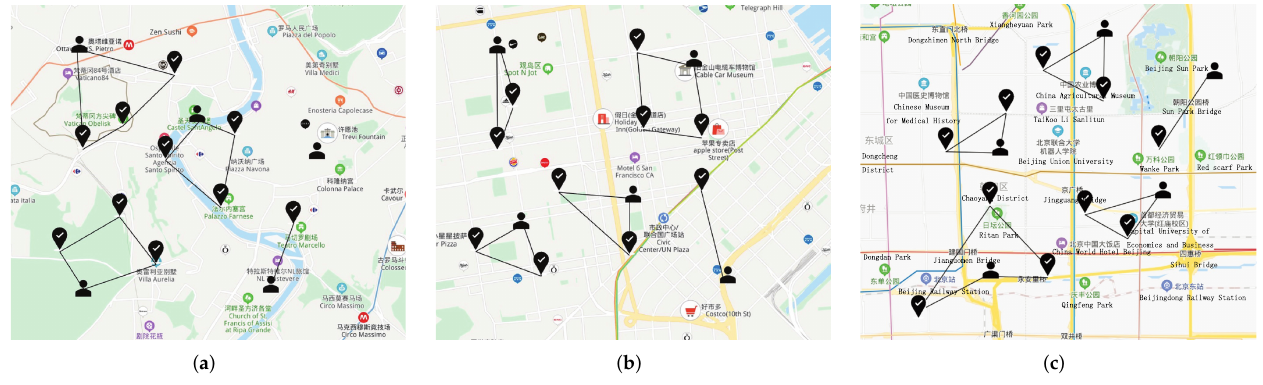
Figure 8. Performance comparisons on the three real-world data sets. ( a ) roma/taxi trace set. ( b ) epfl trace set. ( c ) geolife trace